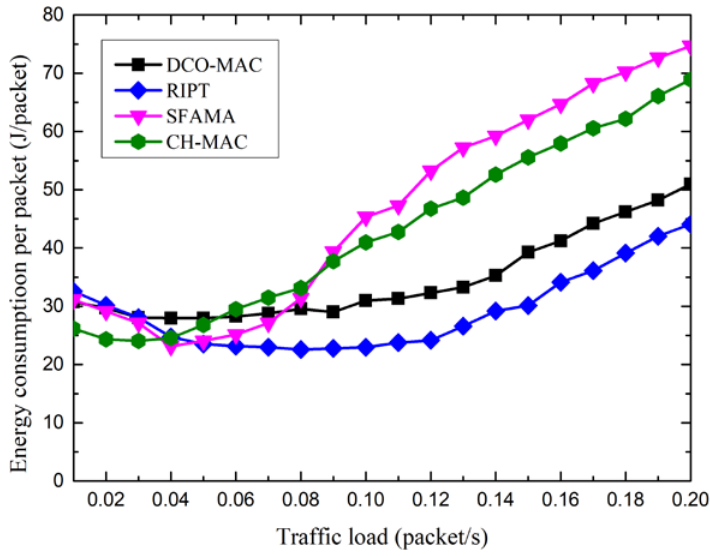
Figure 16. The energy overhead of the DCO-MAC protocol.